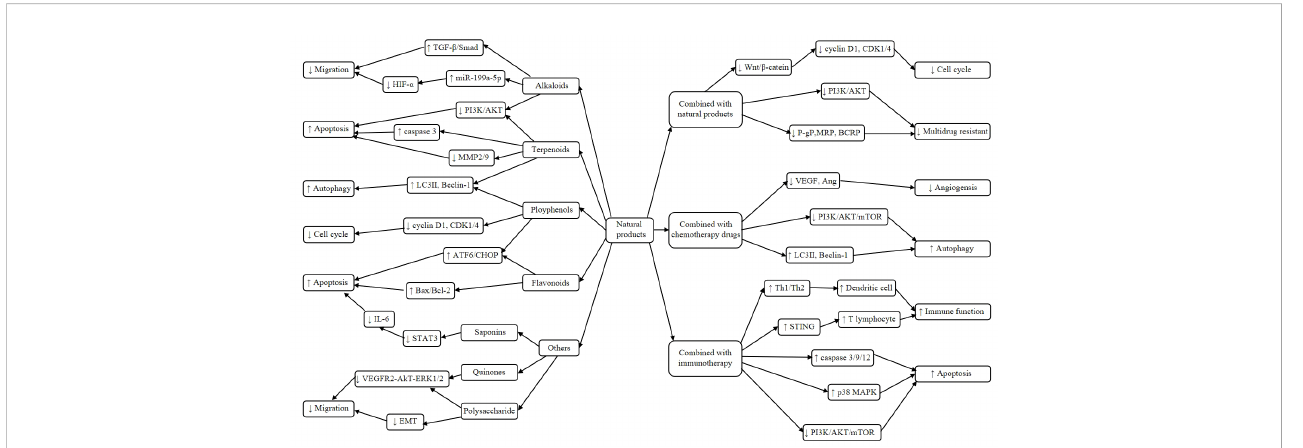
FIGURE 2 Mechanisms of natural products and combination therapy against liver cancer. Alkaloids could inhibits migration through up-regulating TGF- b /Smad and miR-199a-5p, and down-regulating HIF- a expression. Terpeniods promotes apoptosis by inhibiting the PI3K/AKT pathway and the expression of caspase3. It also induces autophagy through up-regulating the expression of LC3II and Beclin-1. Ployphenols inhibits Cyclin D1 and CDK1/4 expression, which in turn block the cell cycle. It also induces apoptosis by activating ATF6/CHOP signaling pathway. Flavonoids induces apoptosis through activation of the ATF6/CHOP pathway and upregulation the ratio of Bax/Bcl-2. Moreover, other natural products inhibit migration through down-regulating VEGFR2-AKT-ERK1/2 signaling pathway and suppressing EMT. Combination of Natural product ingredients inhibits Cyclin D1 and CDK1/4 expression through downregulation of the Wnt/ b -catenin pathway, which in turn inhibits cell proliferation. It also reverses multidrug resistant by decreasing the expression of P-gP, MRP and BCRP. Natural product in combination with chemotherapy suppress angiogensis through down-regulating VEGF and Ang expression. It also induces autophagy by upregulating expression of LC3ii and Beclin-1. Natural product in combination with immunotherapy act by inducing antitumor effects through restoring immune recognition and immune elimination by regulating the immune function. It also induces apoptosis by inhibiting the PI3K/AKT and p38MAPK pathway, which in turn induces